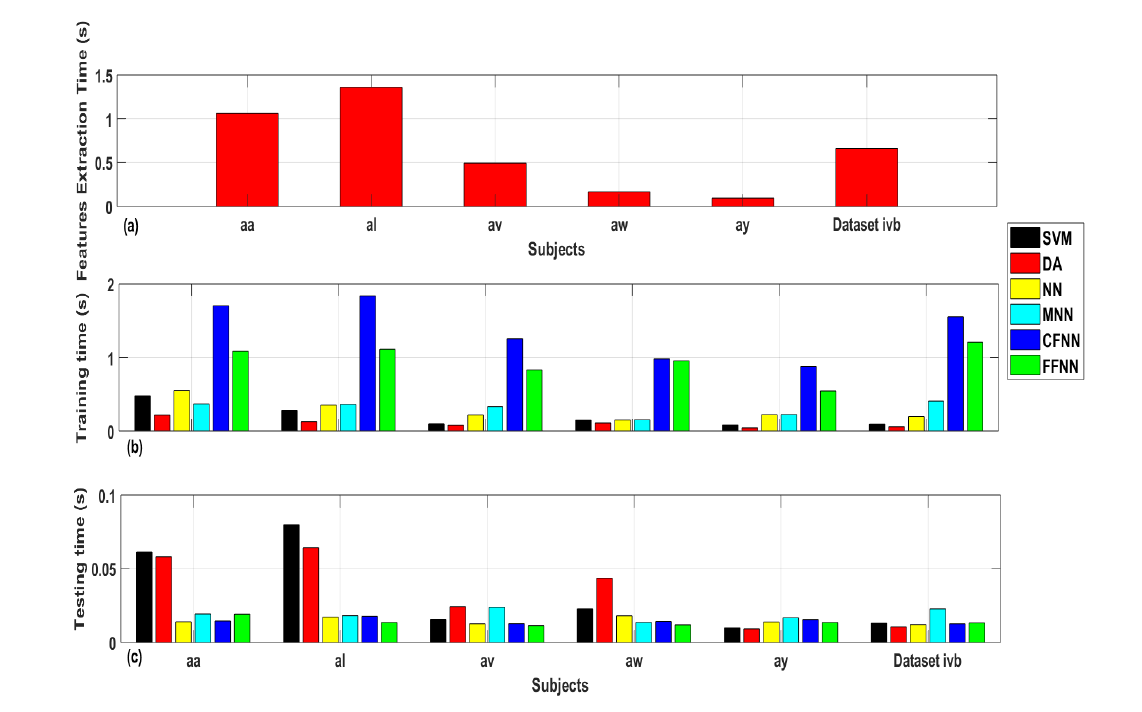
Figure 11. Bar plots representing time complexity: ( a ) Execution Time for SDI feature extraction method. ( b ) Training time. ( c ) Testing